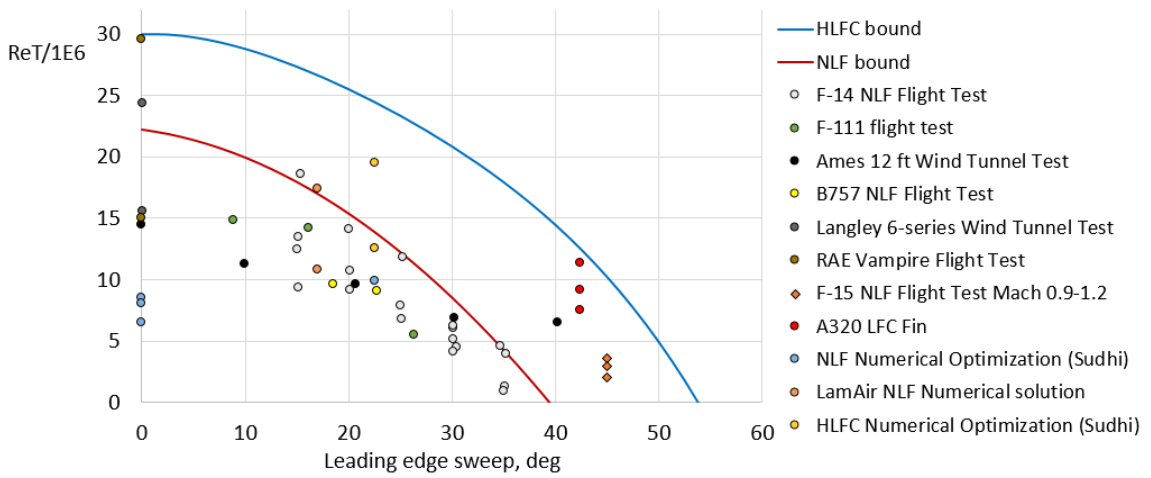
Figure 7. Summary of experimental and numerical analyses of wings and airfoils. Adapted from